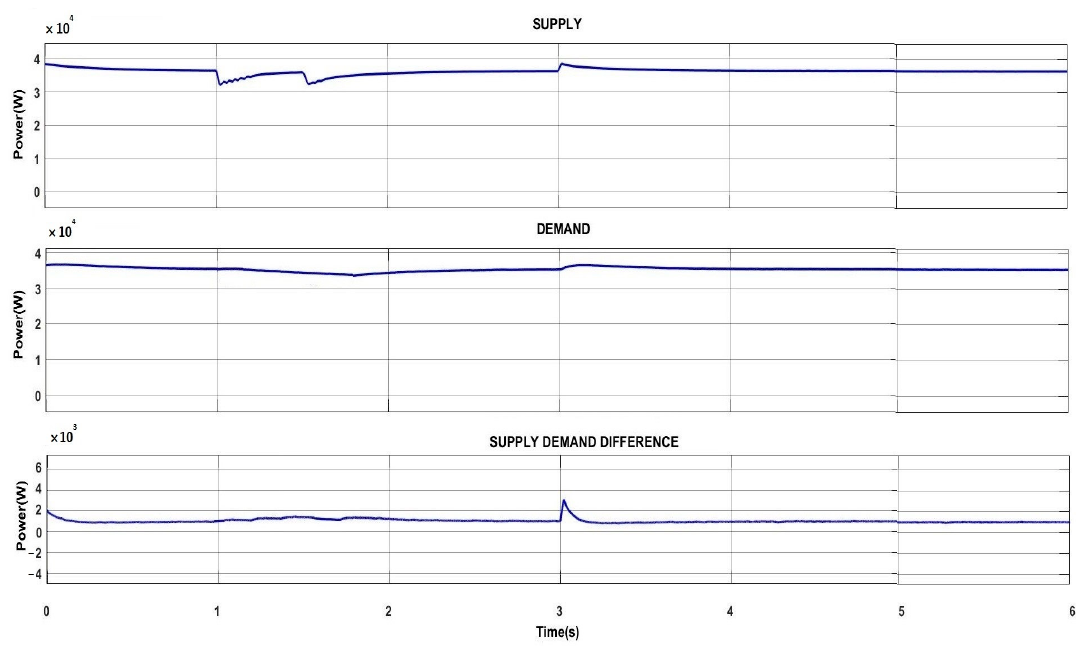
Figure 9. Variation in the generated power and load power in the system.